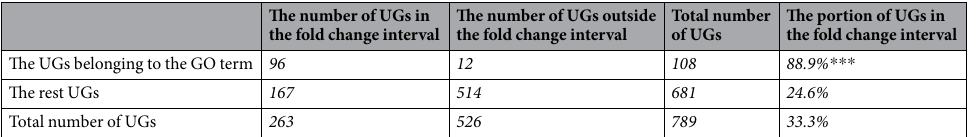
Table 1. Contingency table for the estimation of fold-change-specificity of a GO term. An example of a “translation” GO term and a very weak to weak fold change